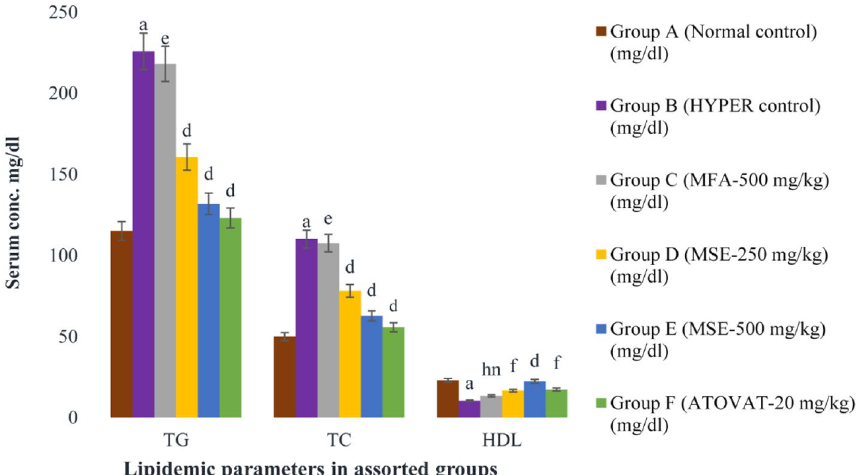
Fig. 5 Comparative expression of TG, TC and HDL at different conc. of MM extracts in HCD mice. The expression of these markers are mean standard error of mean (SEM); where n 5; a P < 0.001; compared with normal control; d P < 0.001; e P < 0.01; f P < 0.05; hn p > 0.05 compared ± = with hyperlipidemic